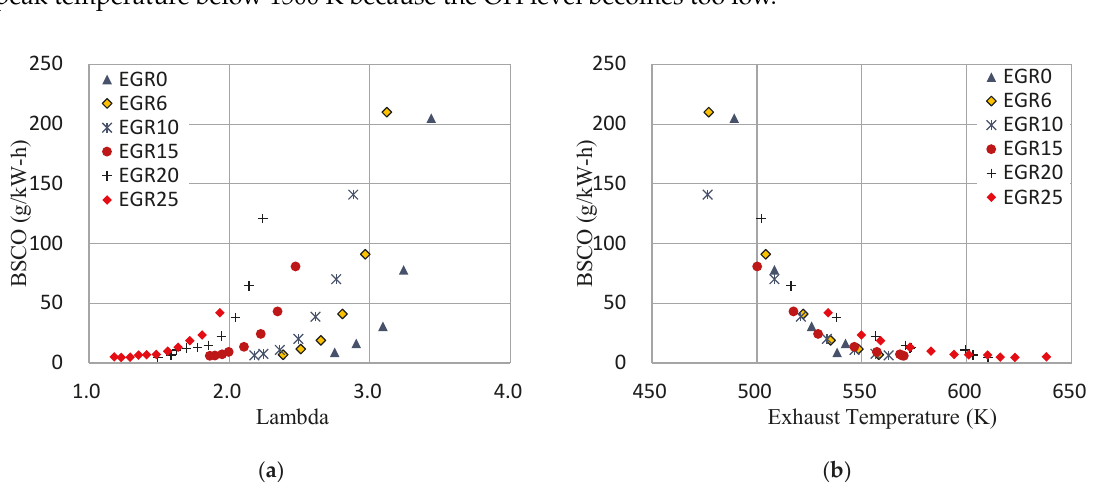
Figure 10. Brake specific CO emission with respect to: ( a ) Lambda; ( b ) Exhaust temperature.